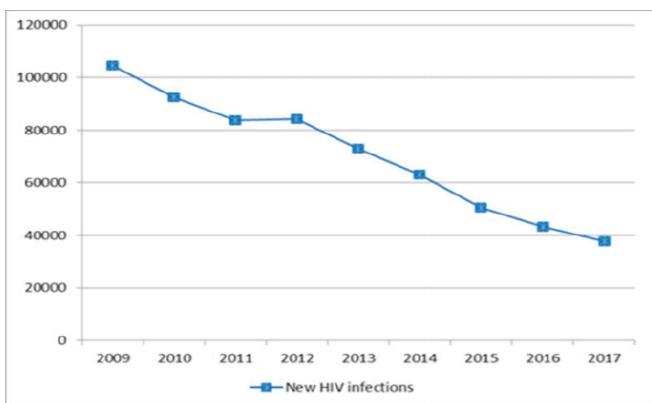
Figure 2: Tanzania HIV incidence projections 2009-2017. (Source: HSHSP IV